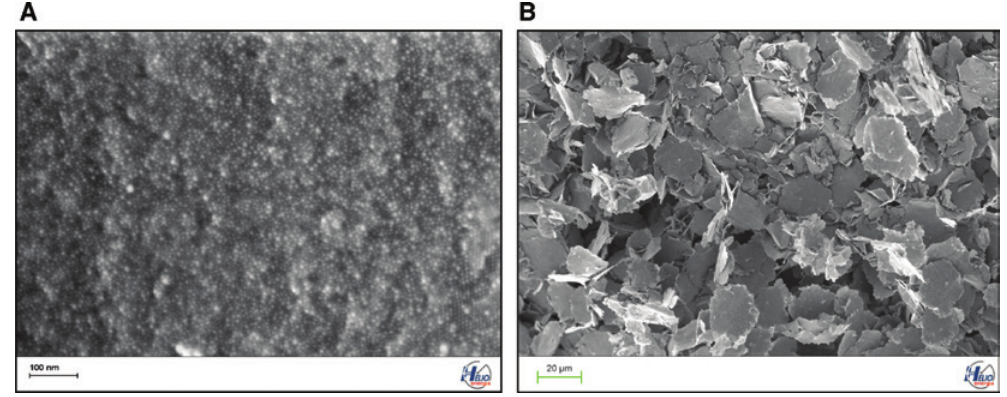
Figure 1: Structure of silver powder: nanosize and spheric shape (A), microsize and flake shape